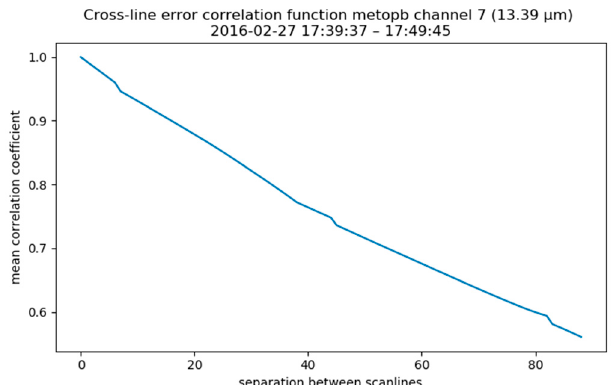
Figure 4. Cross-line error correlation function representative of error correlations from structured effects for the data in Figure 1.